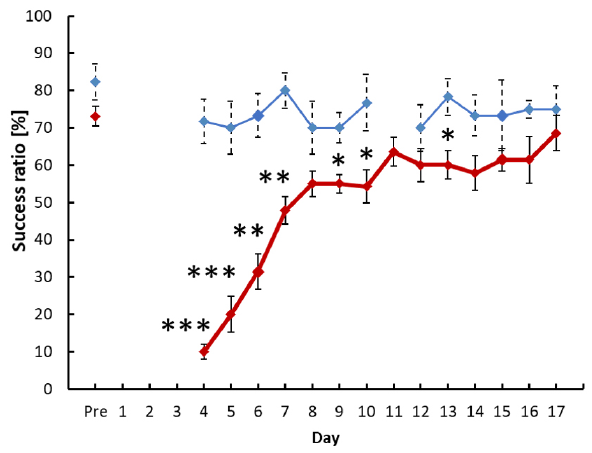
Fig. 5. Changes in the reaching task (RT) success rate. The RT success rate (%) following the cortical lesion is shown. The red line represents the lesioned rats (N = 7), while the blue line the sham-operated rats (N = 3). Before the ablation, both groups of rats performed the test with a success rate of > 70%. *** p < 0.001, ** p < 0.01, * p < 0.05 (Student’s t -test). Data are represented as mean ±